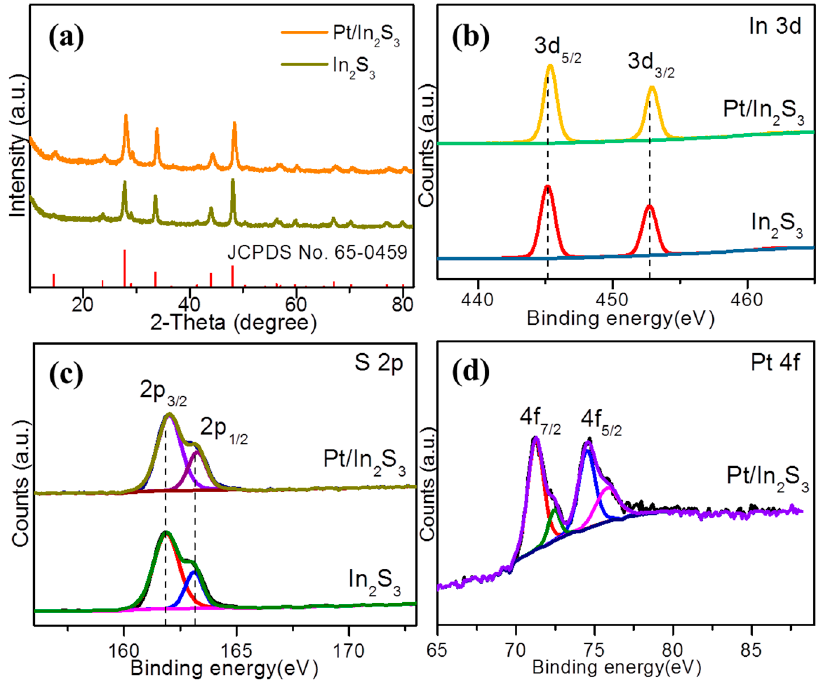
Figure 3. ( a ) XRD patterns of In 2 S 3 and Pt/In 2 S 3 . XPS spectra of ( b ) In 3d, ( c ) S 2p and ( d ) Pt 4f.